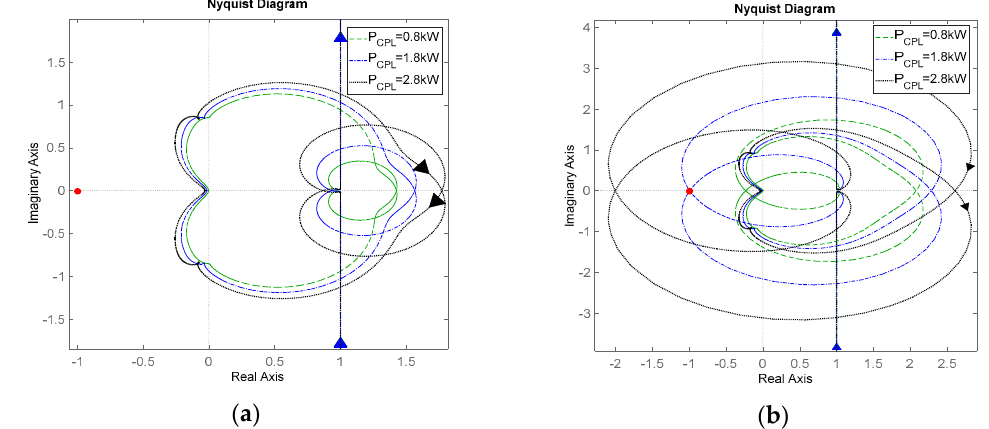
Figure 12. Comparative stability analysis result of the studied dc microgrid system with CPL power changes. ( a ) Proposed NDOB-VNI stabilizing strategy controlled system; ( b ) Conventional droop controlled system.